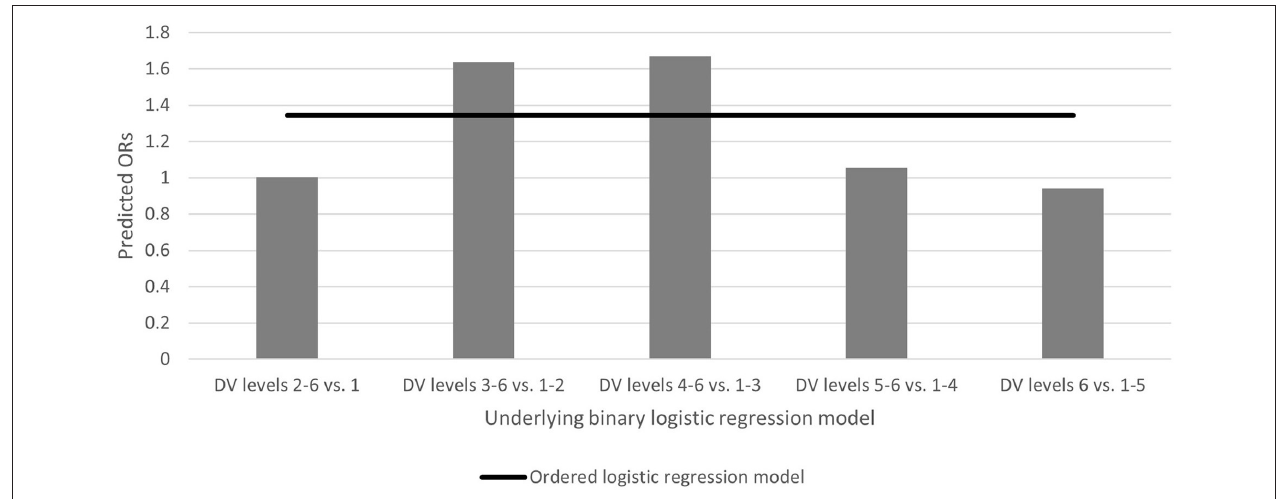
FIGURE 1 | Predicted odds ratios for having a CEPH program, by regression